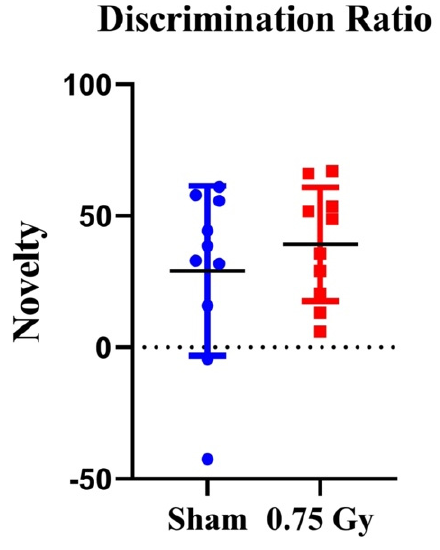
Figure 2. Y-maze discrimination ratio. Sham- and 1 H-irradiated animals displayed a positive dis- crimination ratio. There was no difference in discrimination ratios preferred to explore the novel arm.